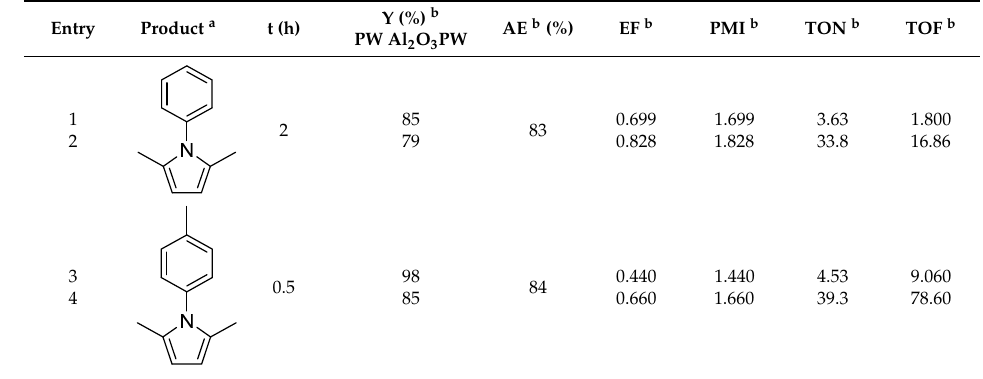
Table 8. Synthesis of pyrrole using bulk (PW) and supported (Al 2 O 3 PW) catalysts. Reaction conditions: amine (1 mmol); acetonylacetone (1 mmol); catalyst PW (40 mg) or Al 2 O 3 PW (40 mg 10% w / w ); solvent-free; temperature 60 ◦ C; stirring.